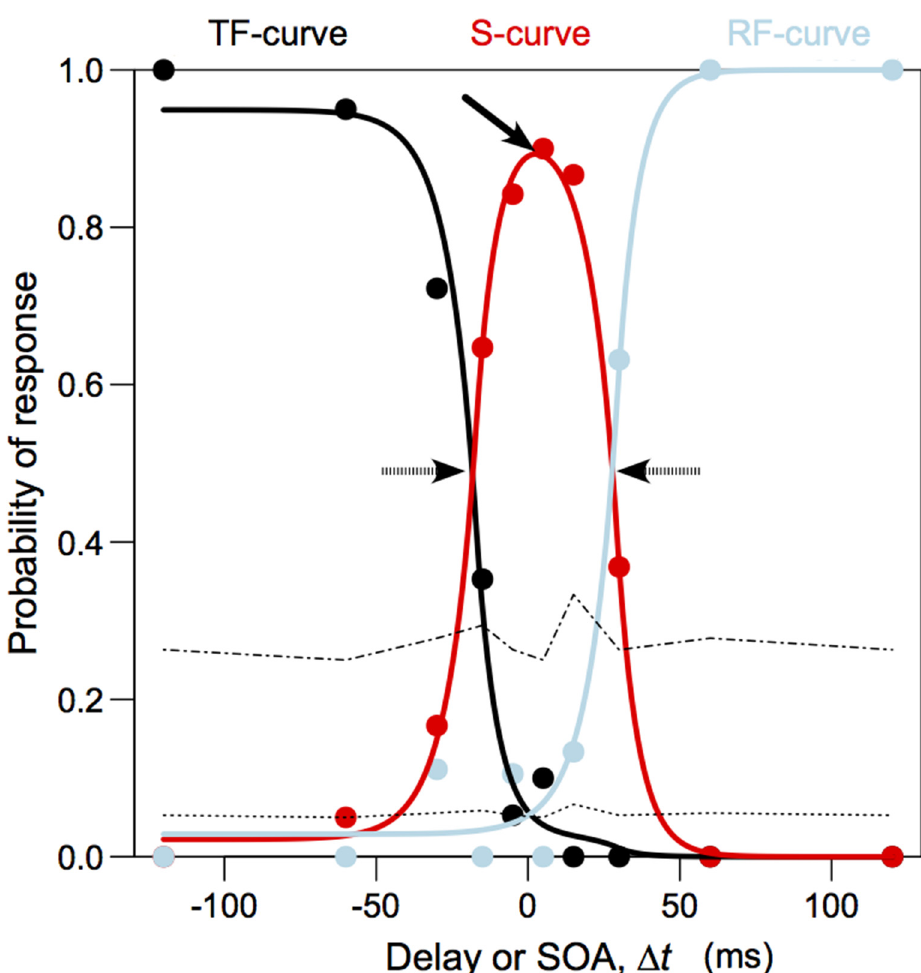
Fig 1. Performance measures in ternary synchrony judgment (SJ3) paradigms. Caption: We derived performance measures from the model that is fitted to the data points (solid dots). Peak PSS is defined as the peak of the S-curve (solid arrow), while midpoint PSS is defined as the midpoint between the intersections of the TF (test stimulus first)- and S (synchronous)-curve, and the RF (reference stimulus first)- and S-curve, respectively (striped arrows). This figure was made using the R-package described in [22] and slightly